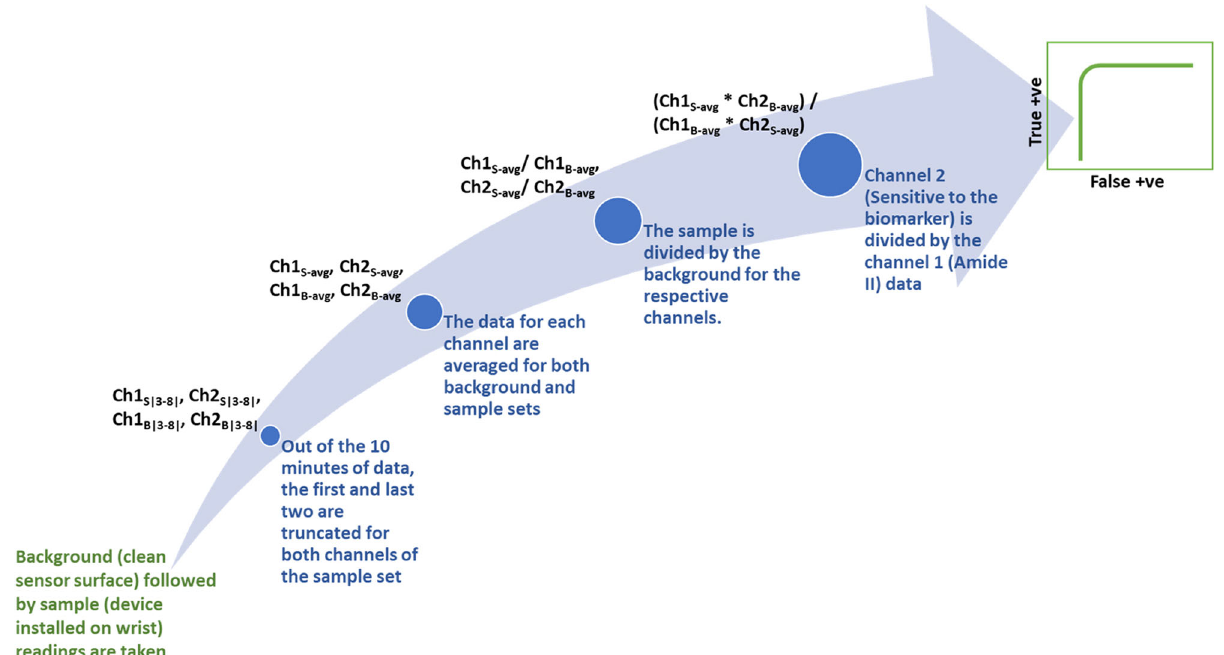
Fig. 1 Data Analysis Schema. Schematic of the data analysis pipeline indicating the trajectory from raw optical data collected transdermally to actionable data used for correlation studies. Two channels refer to the intensities obtained from the two optical windows of the detector. Sample set refers to one complete 10 min data stream. (ATR = Attenuated Total Re fl ectance, SOC = Standard of Care, cTnI = Cardiac Troponin-I).